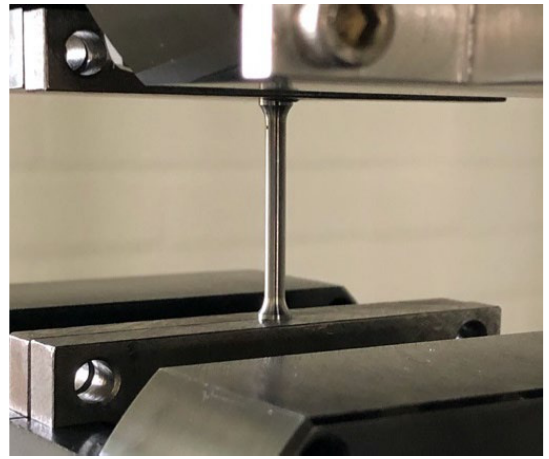
Figure 10. Clamped tensile